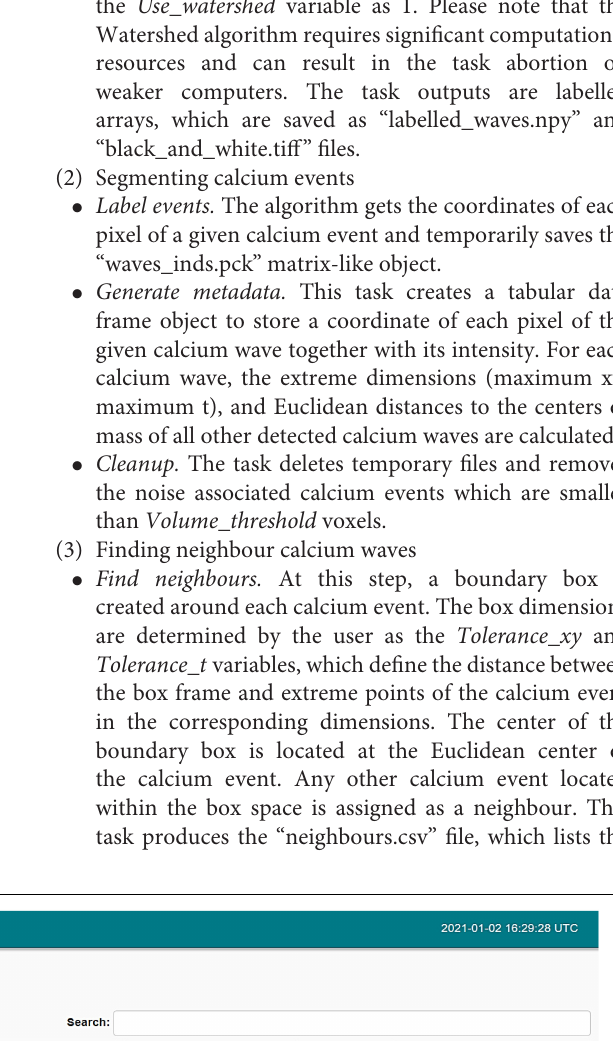
Frontiers in Cellular Neuroscience |